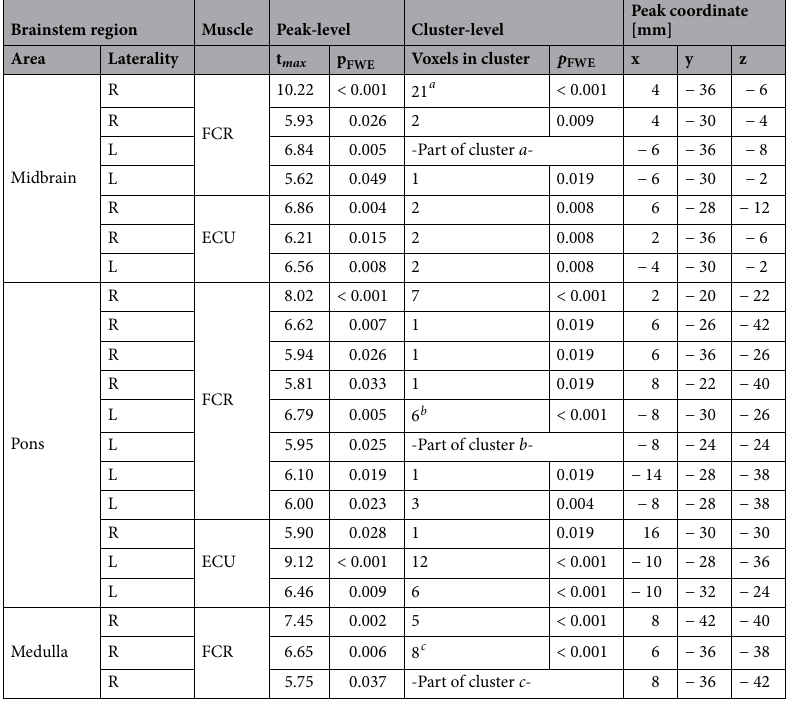
Table 2. Activation in the brainstem. Superscripts on the cluster volume, when present, refer to clusters with multiple peaks. Coordinates are express in MNI